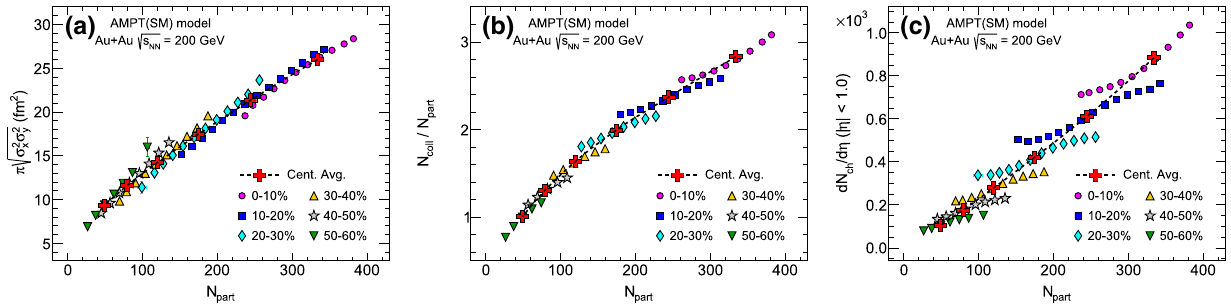
√ s NN = 200GeV. symbol in red, whereas the values for L+R binning in each centrality are shown in solid circles of different